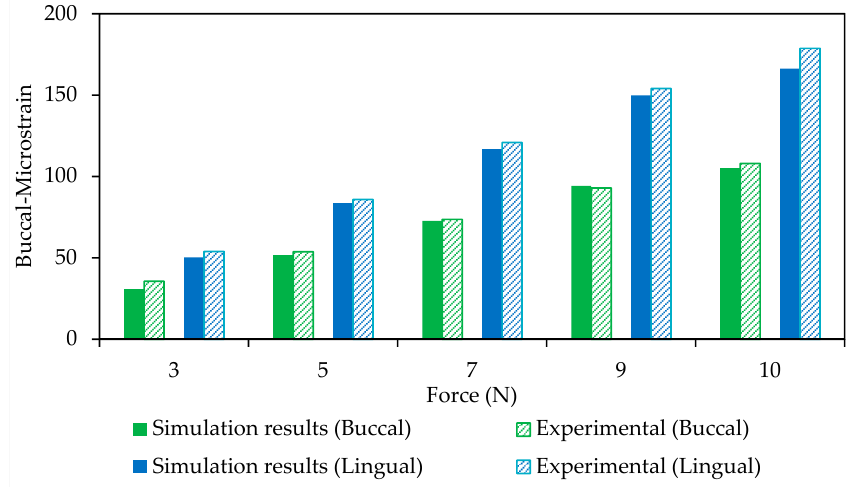
Figure 9. A comparison between FE model and experimental data on the buccal and lingual regions (Model Validation).